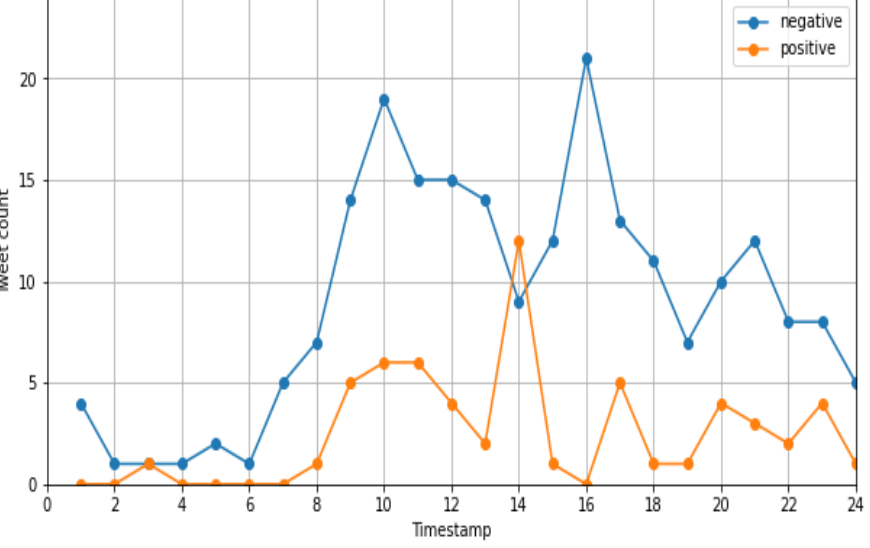
Figure 4. Tweet distribution over 24-h time